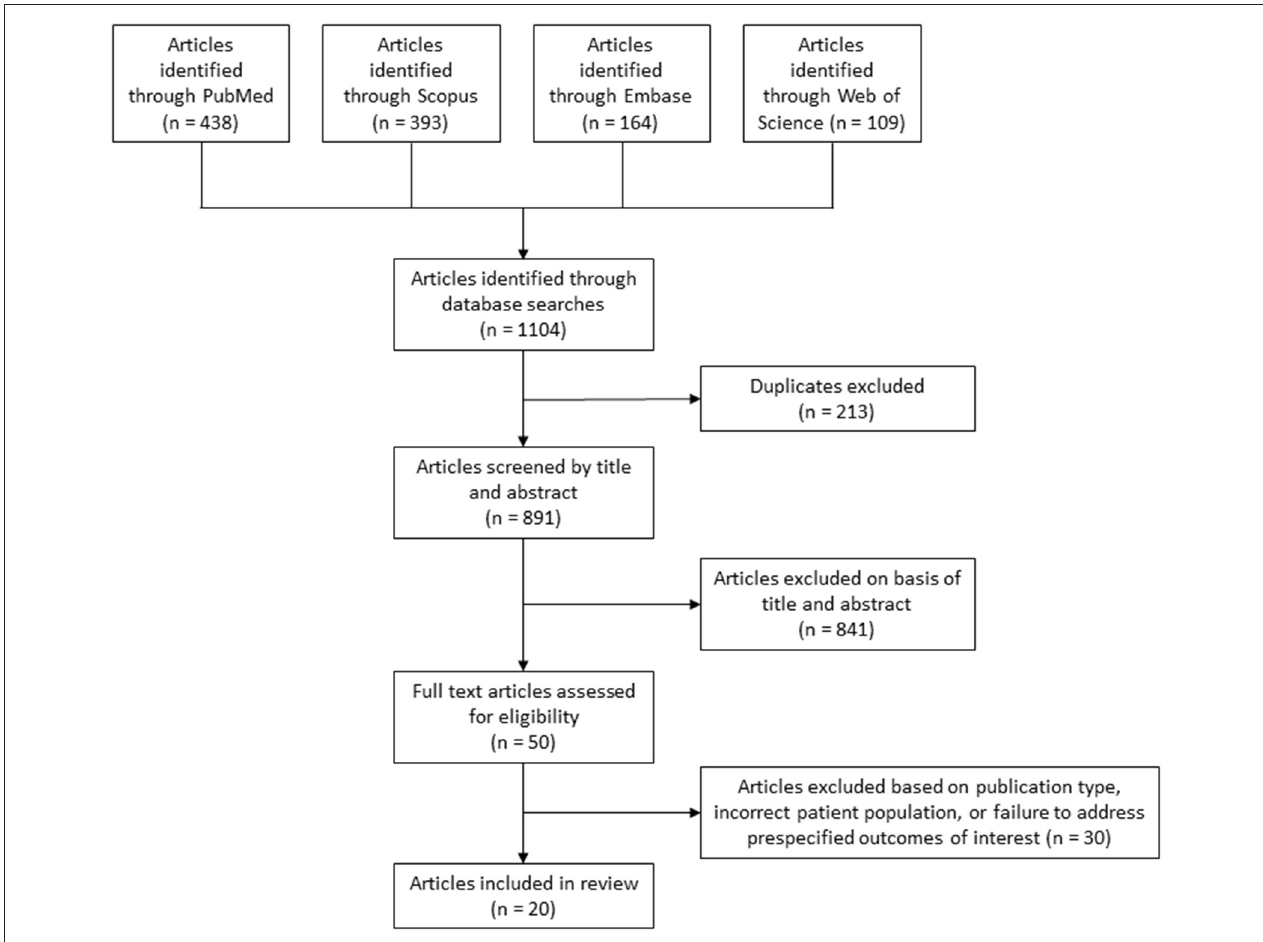
FIGURE 1 | PRISMA flowchart of database search results and article selection